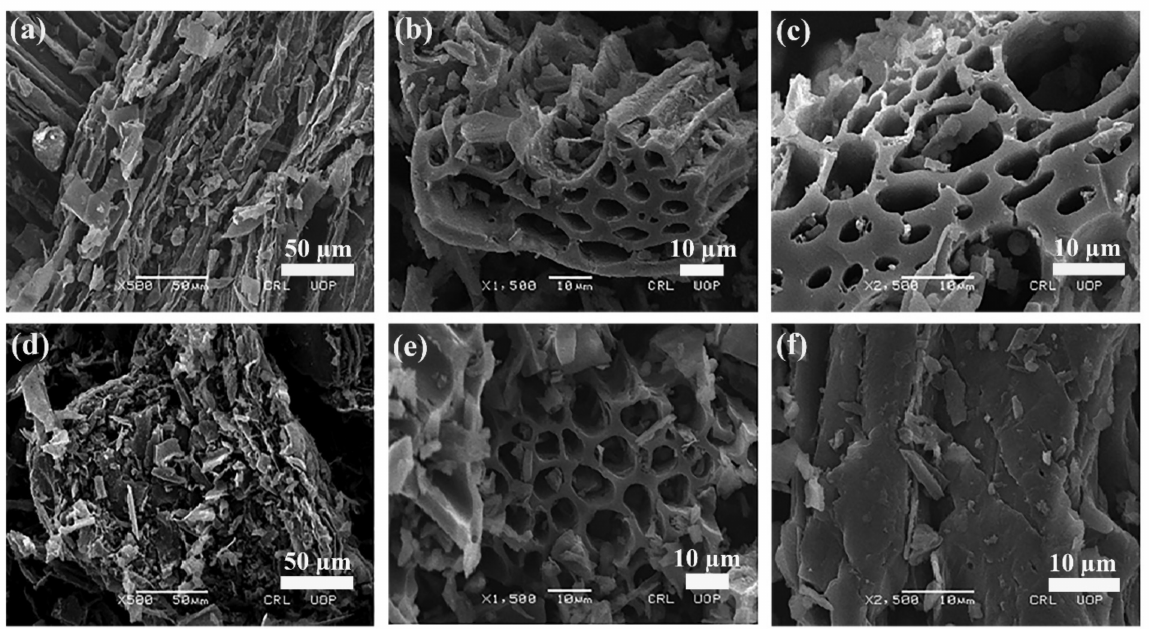
Figure 4. SEM micrographs of BC ZrFe 2 O 5 NCs ( a – c ) and Tartrazine dye-loaded BC-ZrFe 2 O 5 NCs ( d – f ) at three different magnification